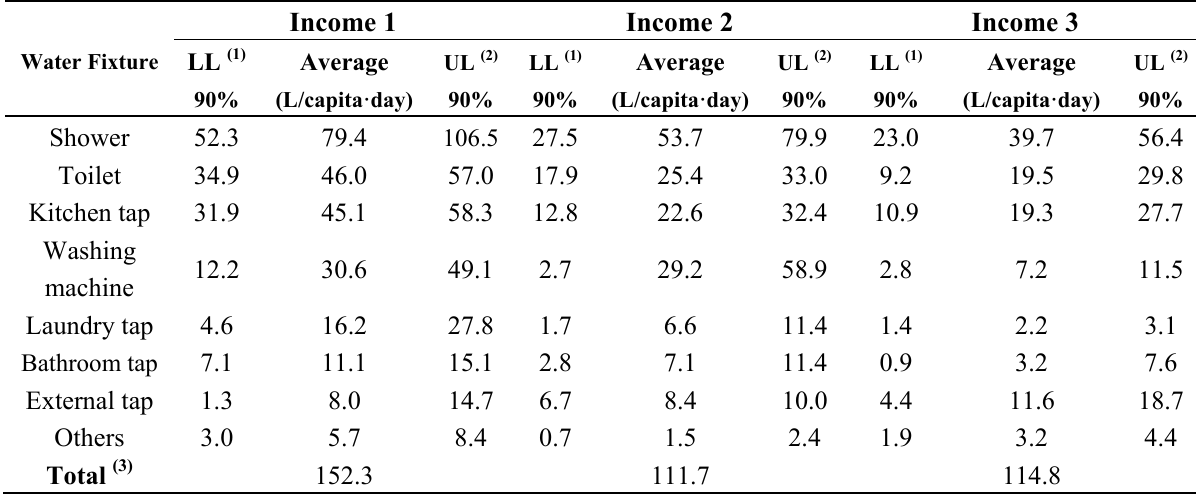
Table 4. Average, lower and upper limit values for the daily water consumption ( per capita ) in water fixtures and appliances.